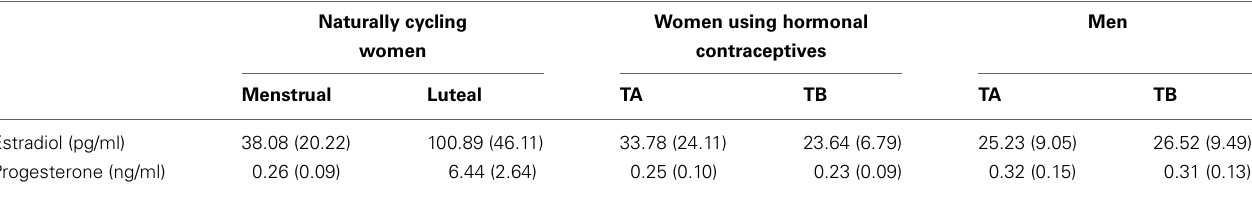
Table 2 | Means and standard errors (in brackets) of estradiol (pg/ml) and progesterone levels (ng/ml) of naturally cycling women, women using hormonal contraceptives, and men during the menstrual/luteal phase and test session A/B (TA/TB),